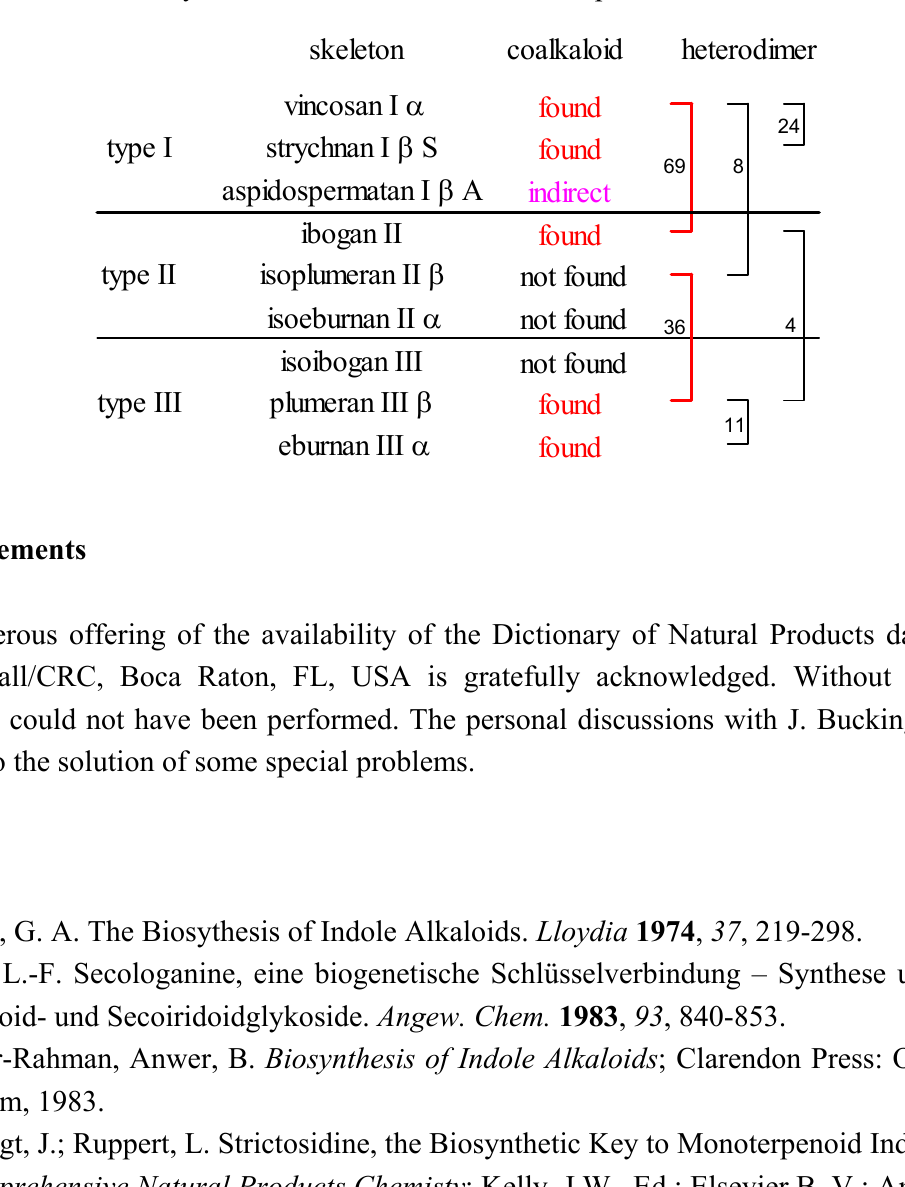
Table 2 . Summary of Chemotaxonomic Relationships between Indole